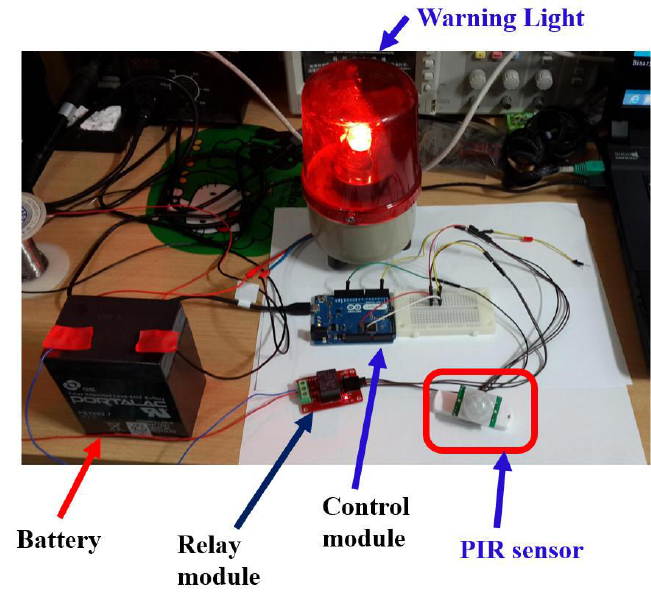
Figure 23. Personnel near the PIR sensor, the warning light will turn